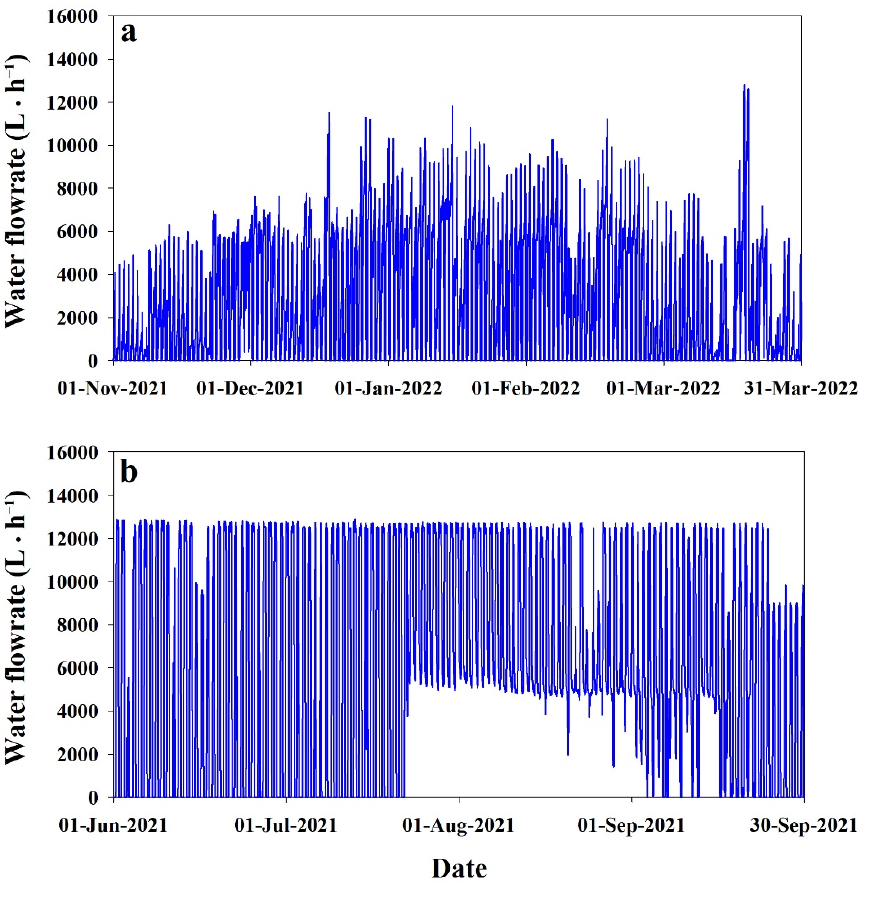
Figure 7. Storage tank to greenhouse water flow rate in ( a ) winter and ( b ) summer.